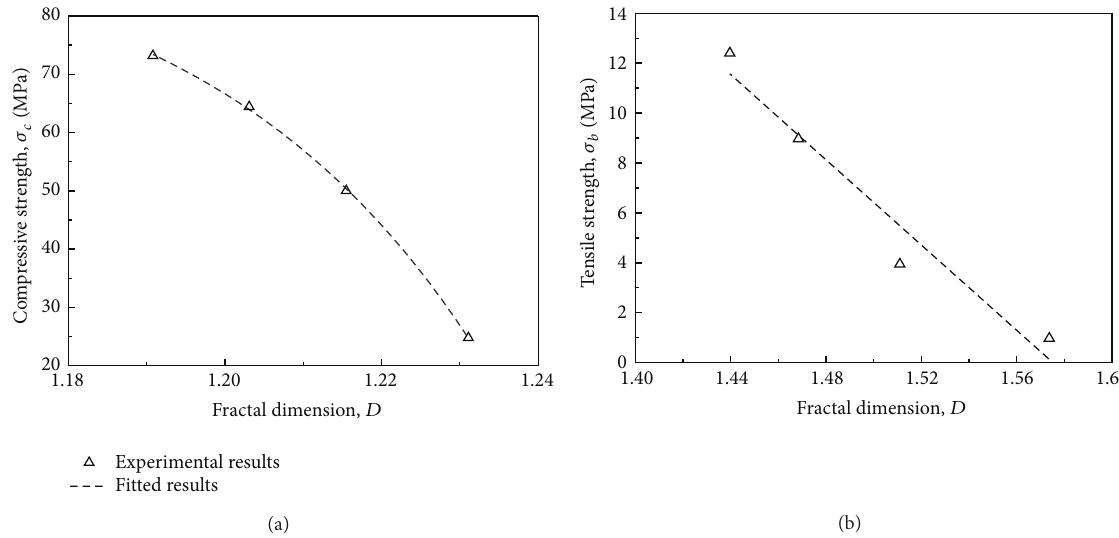
Figure 5: Mechanical properties versus fractal dimension for (a) porous metal powder materials and (b) porous metal fiber materials.